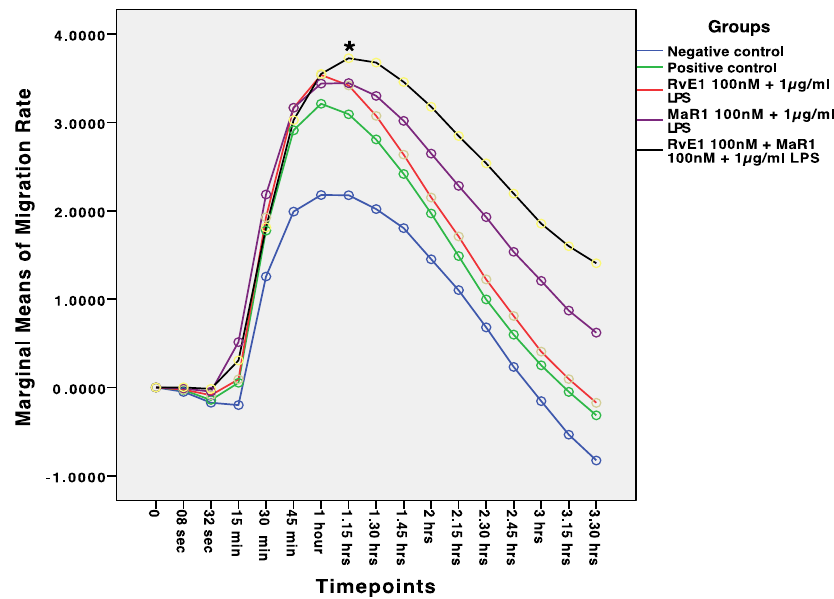
Figure 3. Comparison of mean migration values among the five study groups across different time points. The migration assays experiments were repeated three times ( n = 3) and the mean value of migration of * Group-5 (RvE1 100 nM + MaR1 100 nM + 1 μ g/mL LPS), was significantly higher than the other four study groups across 1 h to 3.30 h ( p ≤ 0.0001).